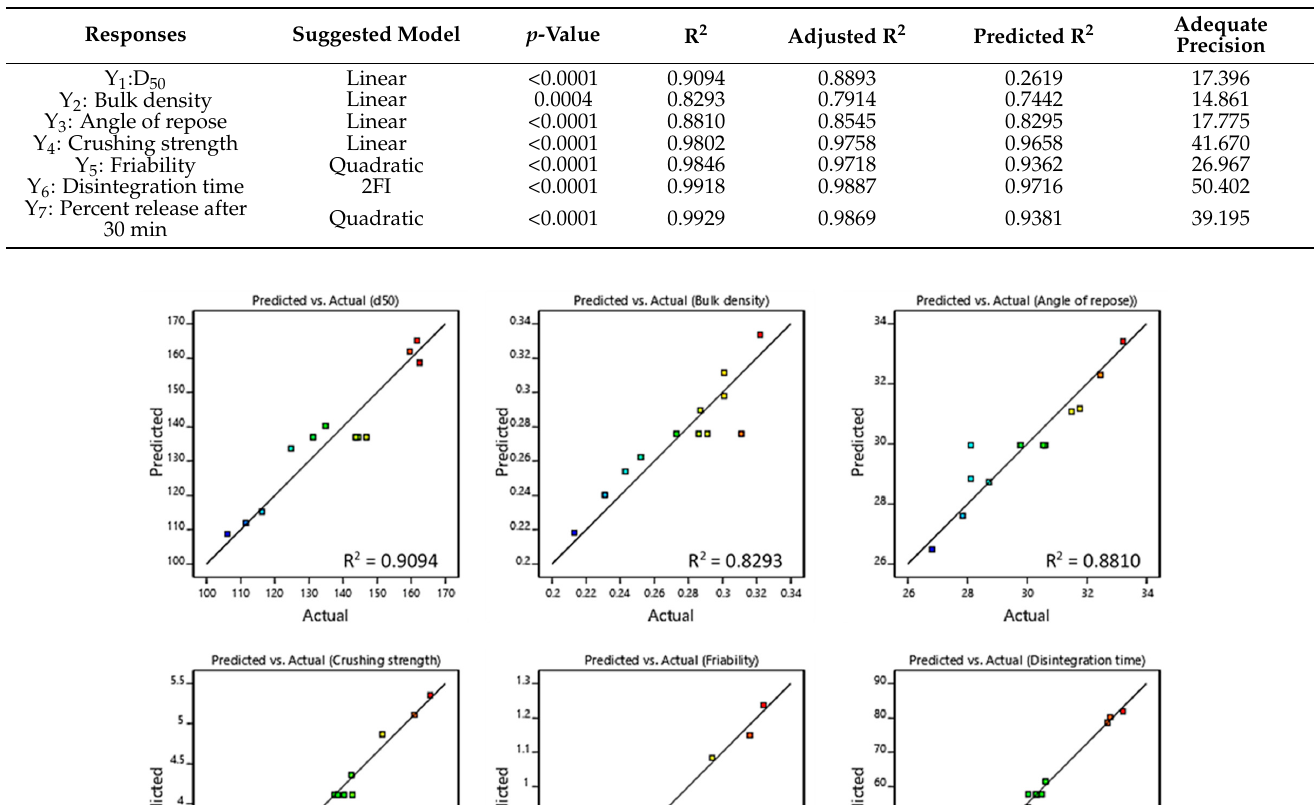
Table 4. Summary of model fitting and statistical analysis.